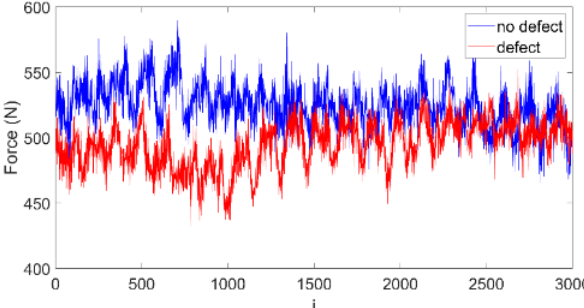
Figure 5. Cutting forces measured when drilling CFRP without defect (blue line) and with defect (red line).